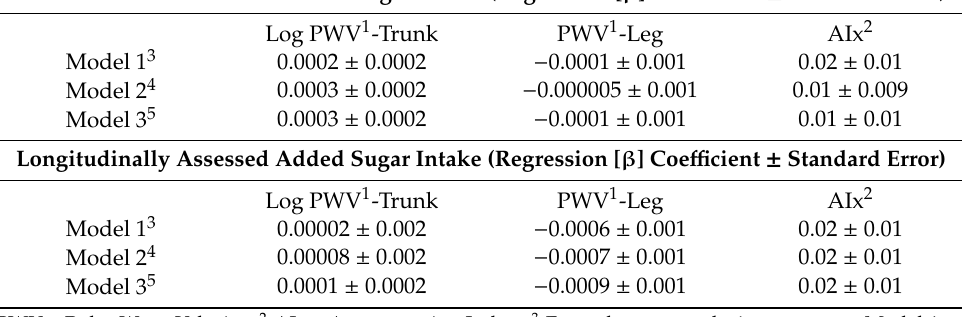
Table 2. Multivariate regression models between cross-sectionally and longitudinally assessed added sugar intake (area under the curve estimate of average added sugar intake over the study duration, 2–12 years) with arterial sti ff ness measures in youth with type 1 diabetes (T1D). Cross Sectional Assessed Added Sugar Intake (Regression [ β ] Coe ffi cient ± Standard Error)